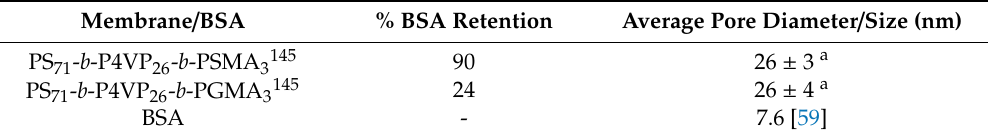
a Determined by analyzing the SEM surface